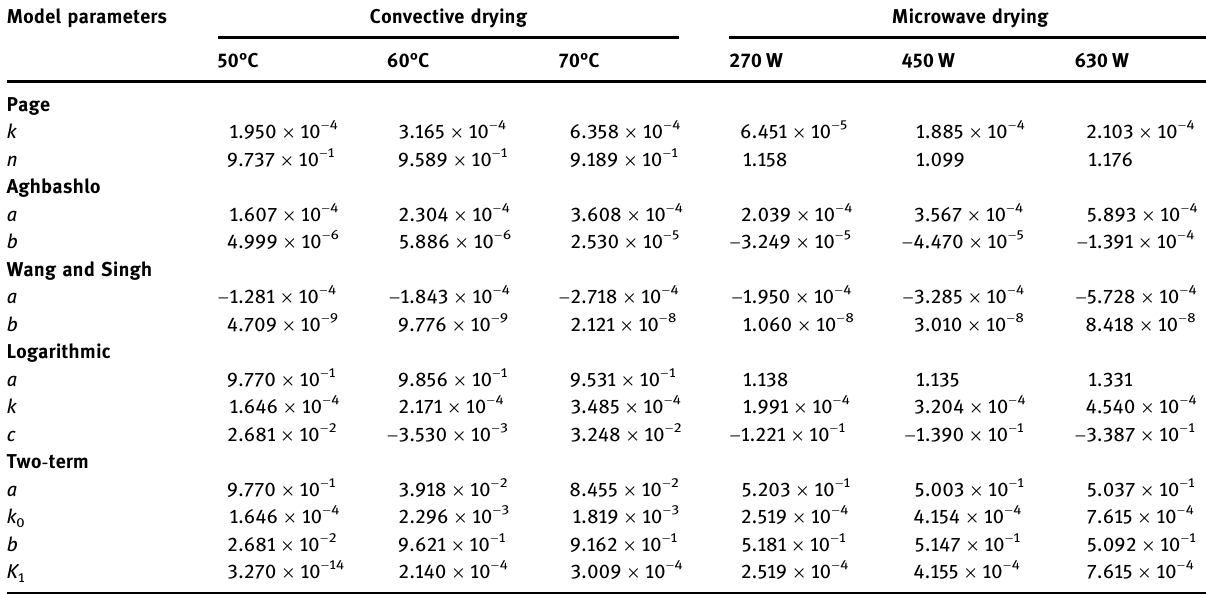
Table 4: Model parameters for equations in Table 1 obtained for experimental fi tting of the data for CV and MW drying of pomegranate arils Model parameters Convective